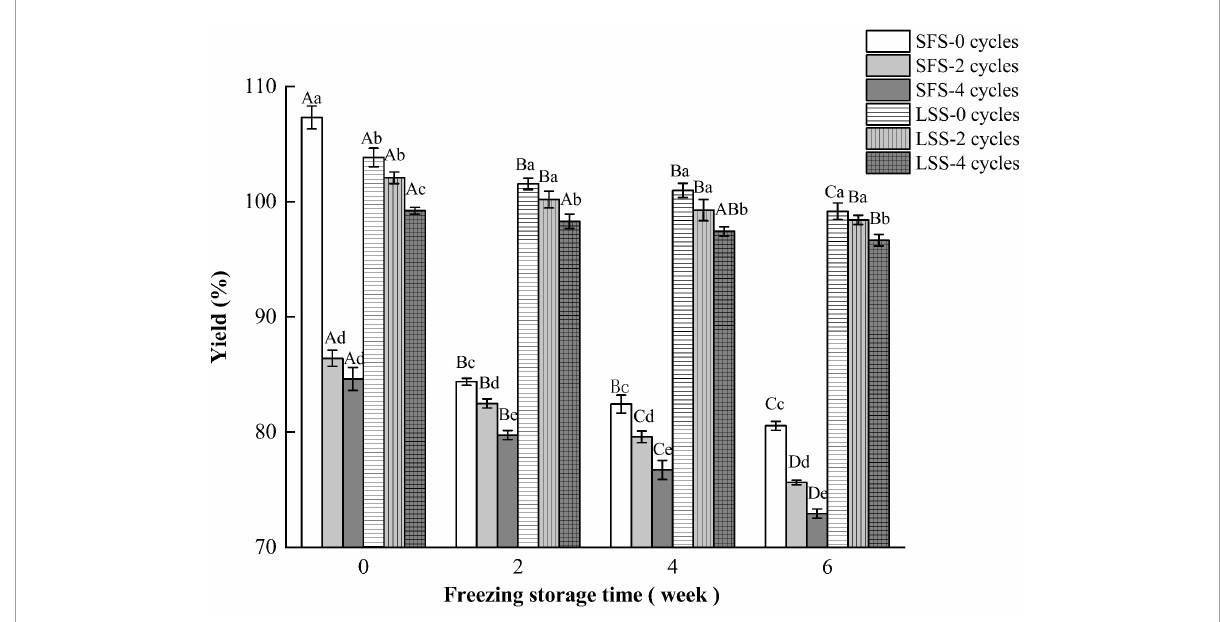
FIGURE1 Variation in yield of LYC during frozen storage. SFS and LSS represent the salt-free soaking group and low-salt soaking group, respectively. Lowercase letters represent significant differences between six samples during freezing, and capital letters represent significant differences between samples of different treatment groups during freezing ( P <